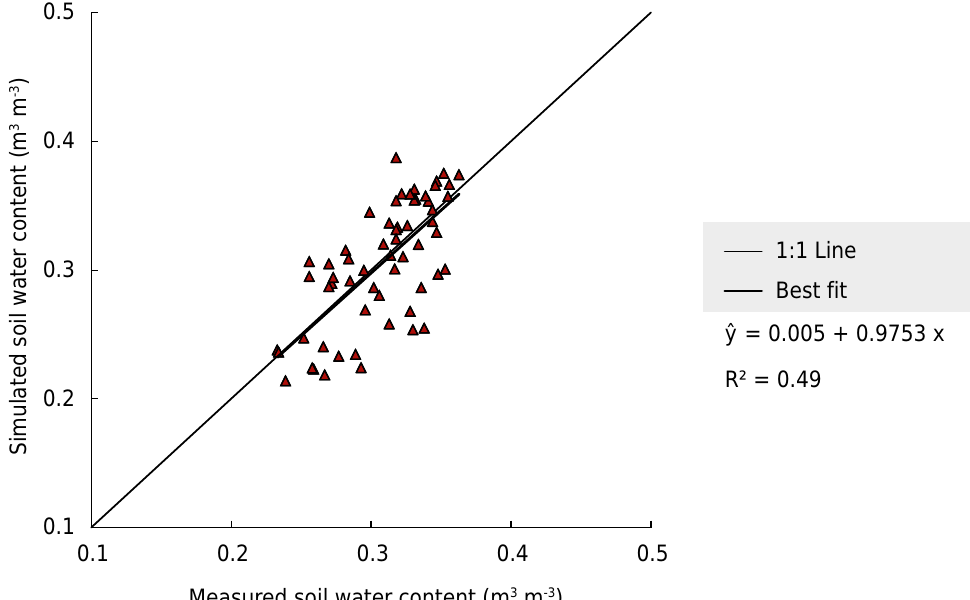
ŷ = 0.005 + 0.9753 x R² = 0.49